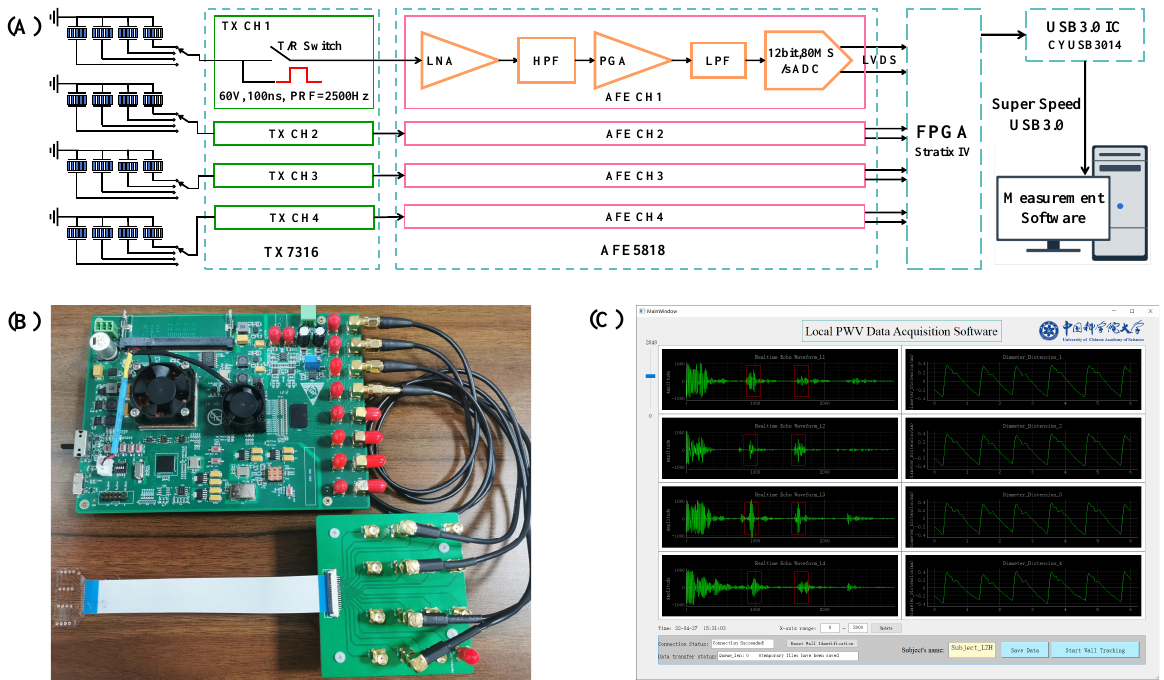
Figure 4. Data acquisition system. ( A ) Multi-channel ultrasound system hardware architecture. ( B ) Electronics hardware board. ( C ) A screenshot of the software graphical user interface